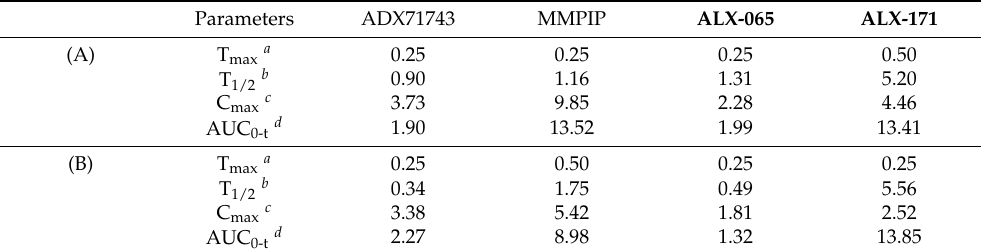
Table 2. Plasma (A) and brain (B) concentrations of ADX71743, MMPIP, ALX-065, and ALX-171 after i.p. administration of 10 mg/kg (mouse, Albino